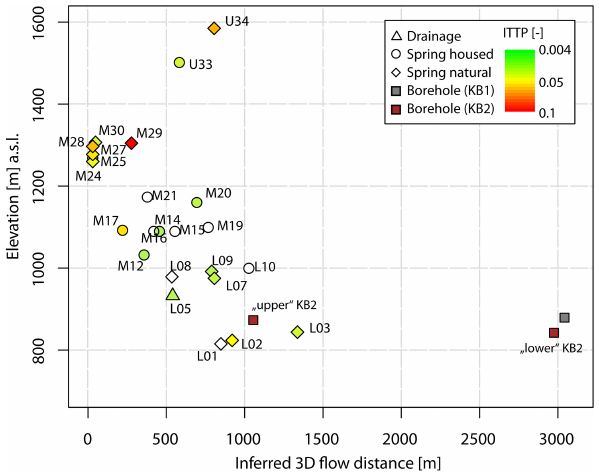
Figure 10. Relation between inferred 3D flow distance and dis- charge elevation. Colours represent calculated ITTP following Tet- zlaff et al. (2009) for which calculations were feasible. Sampling dates are in conformity with data points in Fig.